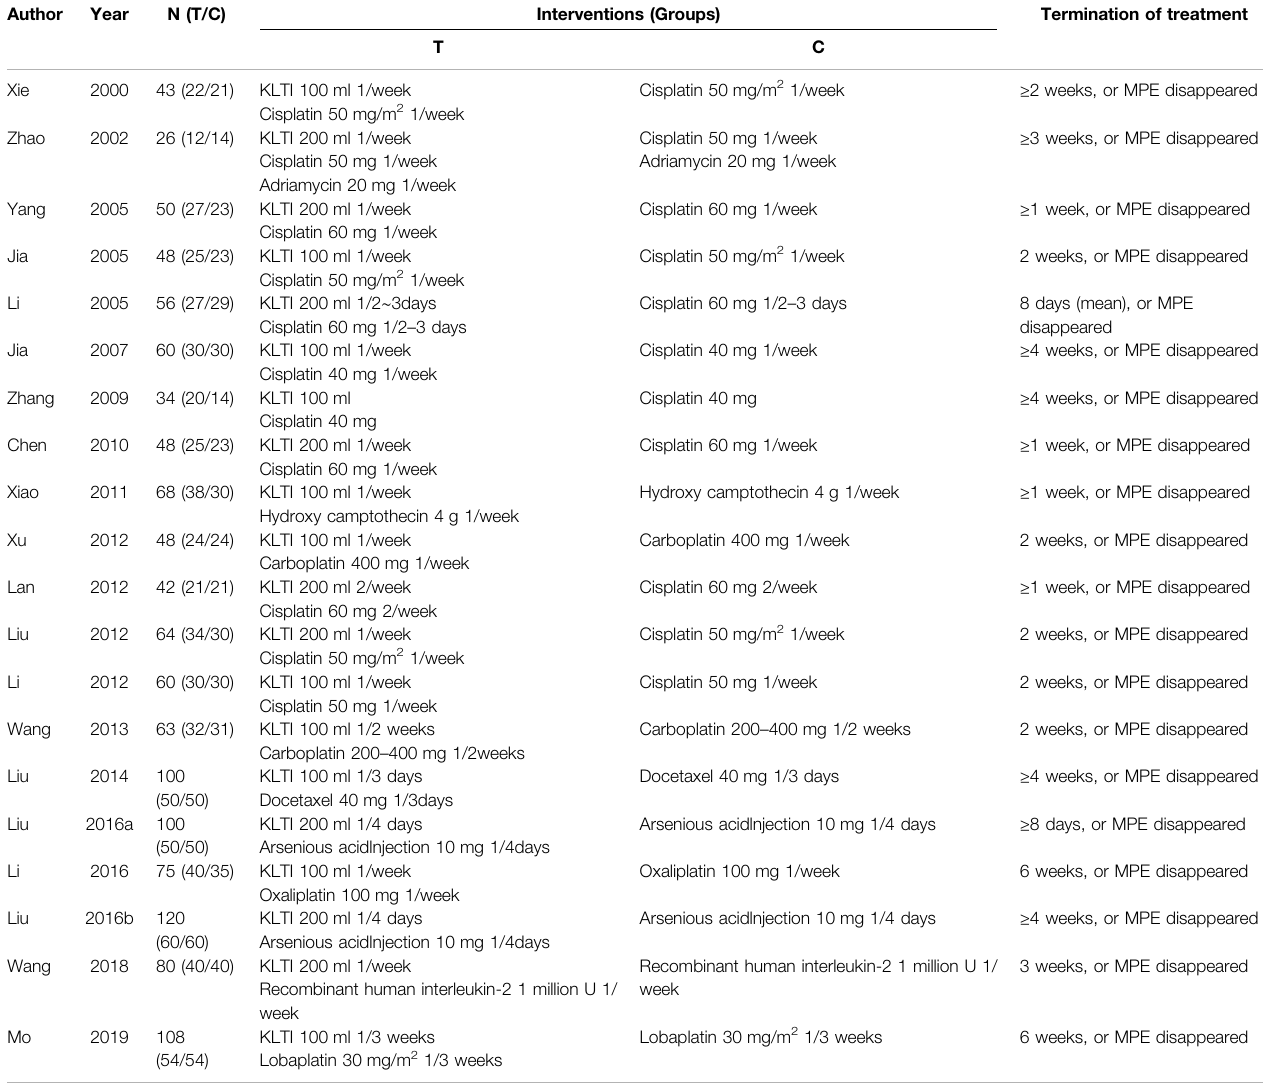
TABLE 2 | Assessment method of administration of included